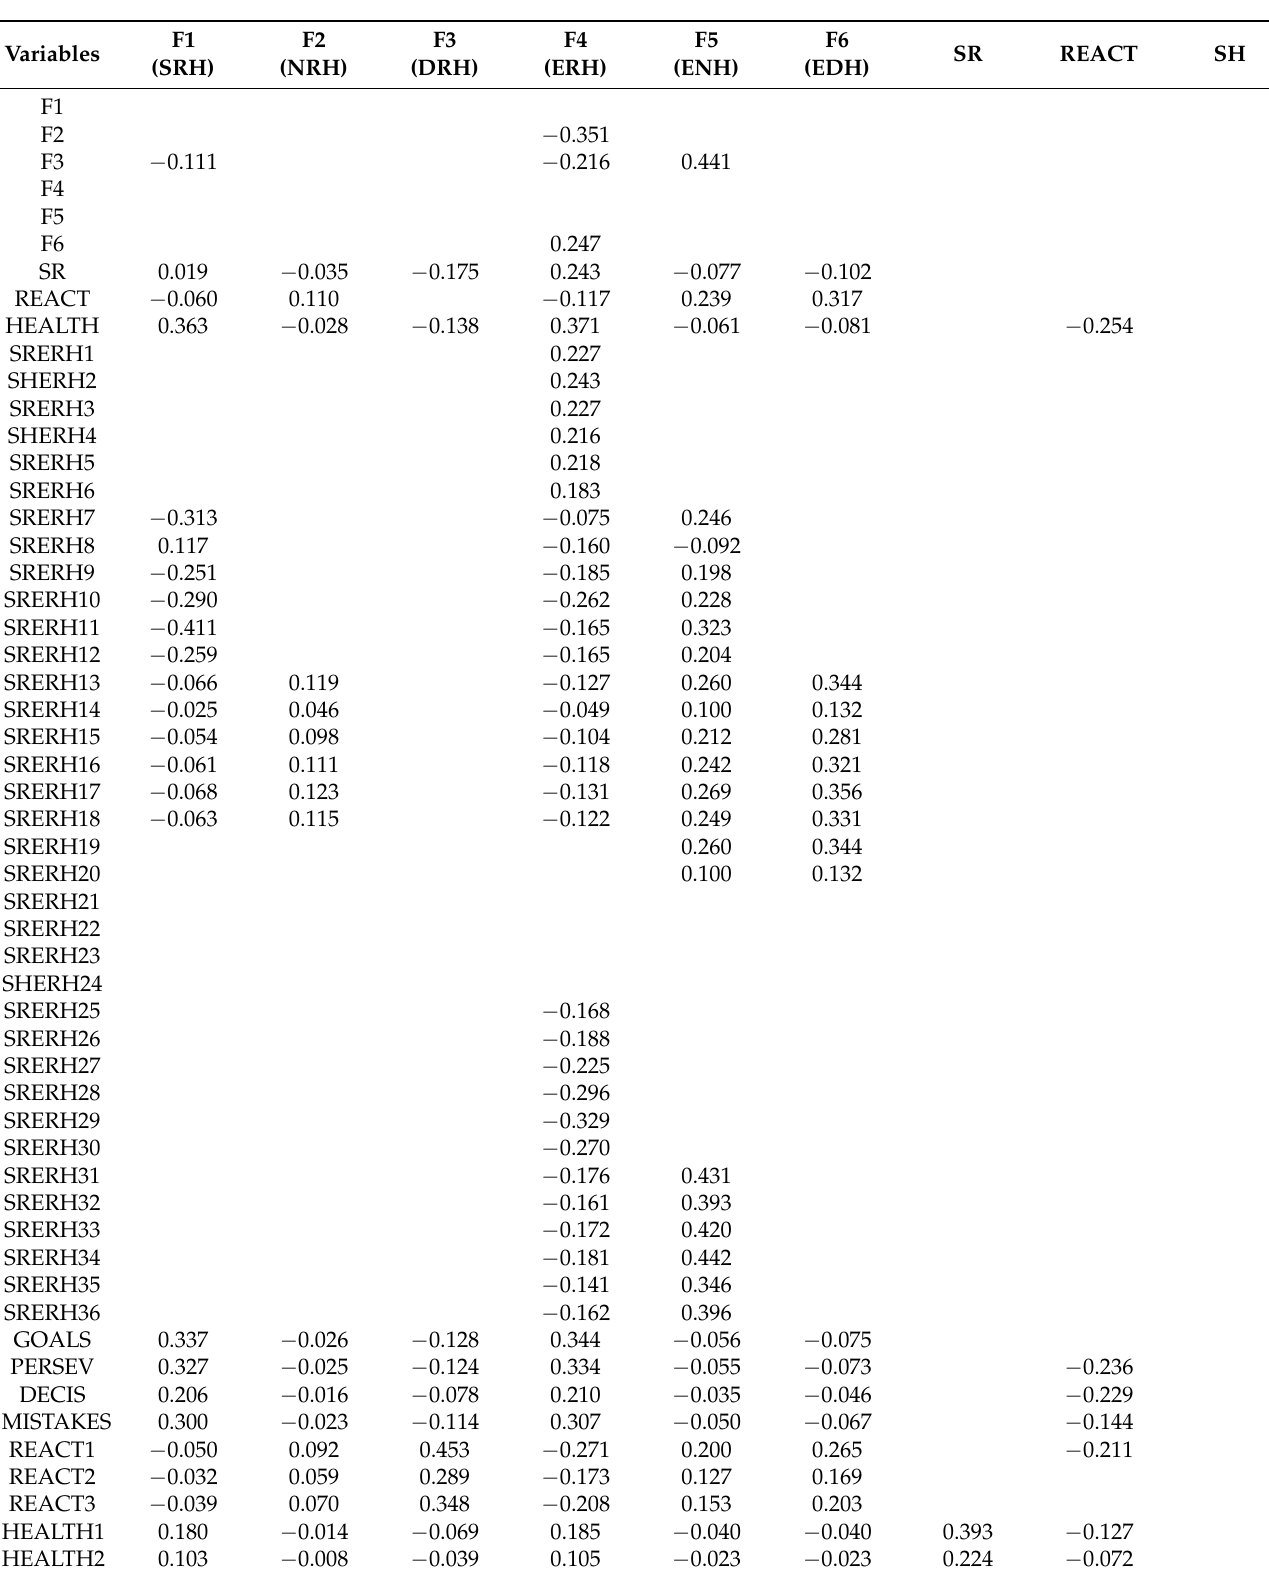
Table 9. Standardized indirect effects (default